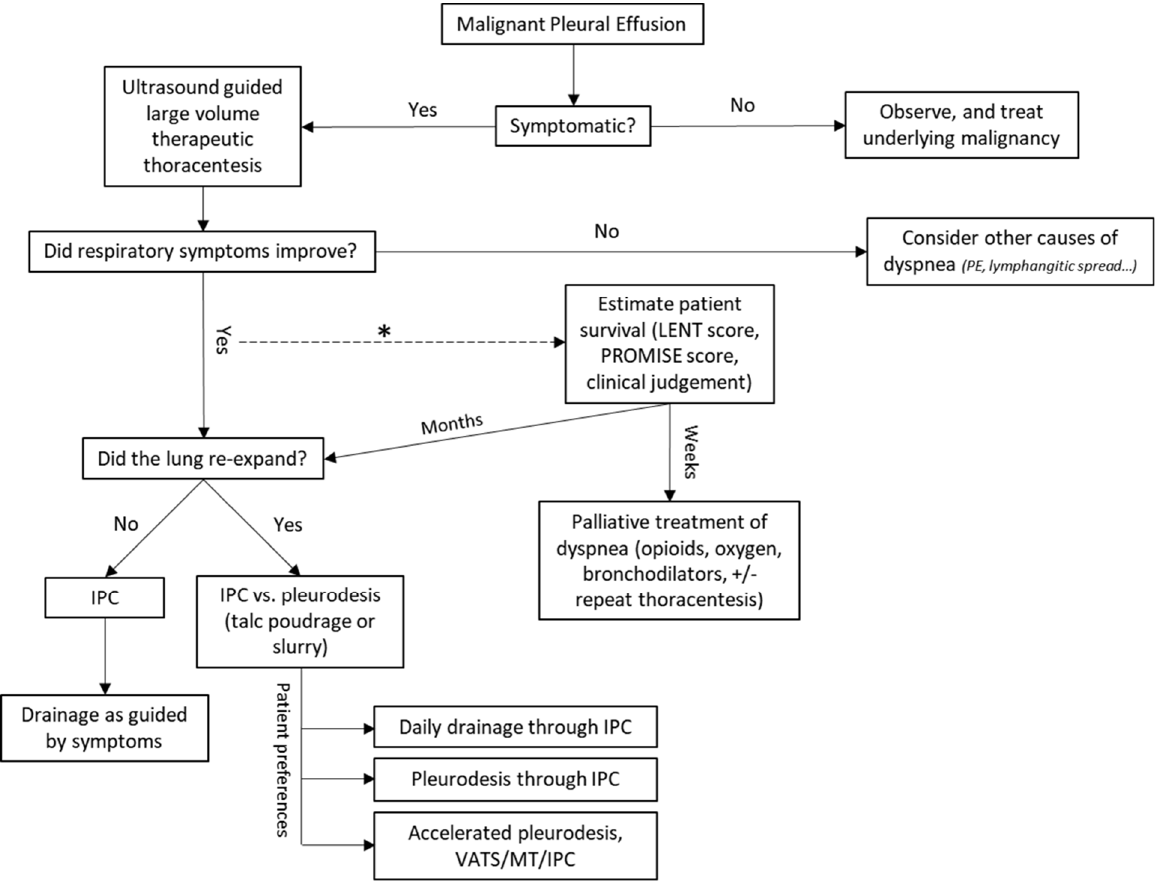
Figure 1. Suggested MPE Management algorithm (adapted from Feller-Kopman et al. [7]). IPC (indwelling pleural catheter), VATS (video assisted thoracoscopic surgery), MT (medical thoraco- scopy). * The role of prognostication scores in clinical practice is still unclear, and physicians’ pre- diction of survival is not very accurate; therefore, a “predicted” short survival should be inter- preted with caution.